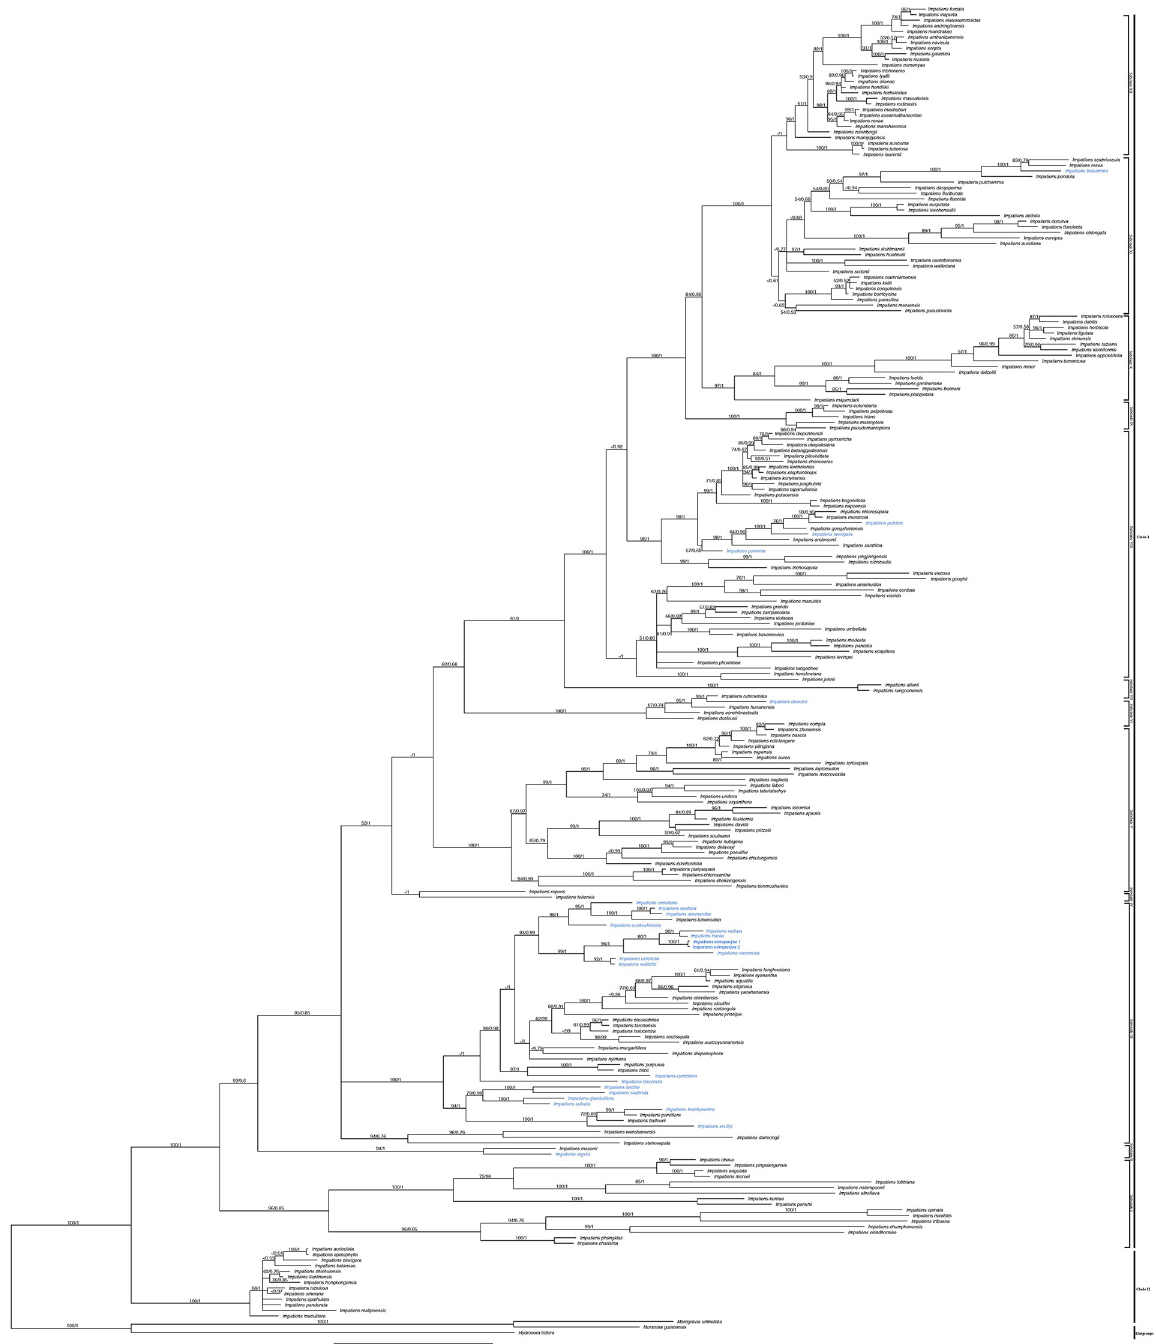
Fig 1. Bayesian inference tree of Impatiens based on the combined nuclear (ITS), and chloroplast ( atpB-rbcl ) markers. Numbers above branches indicate bootstrap percentages (BS MP ) for MP analyses and posterior probabilities (PP) for BI analysis, respectively. Asterisk ( � ) indicates BS MP = 100 and PP = 1.0, a dash ( − ) indicates support at a node < 50%. Scientific name marked in blue color indicates species occurring in Nepal.